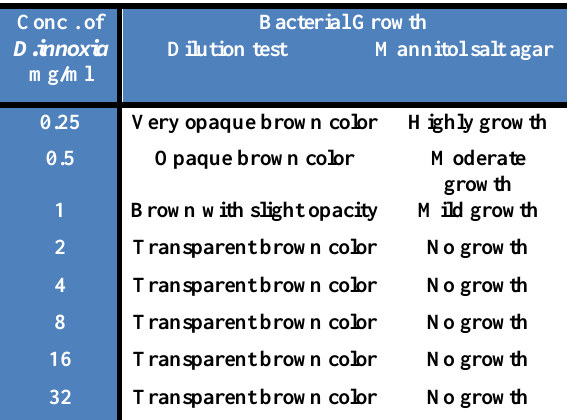
Table, 1: MIC of D.innoxia extract in broth and agar media.